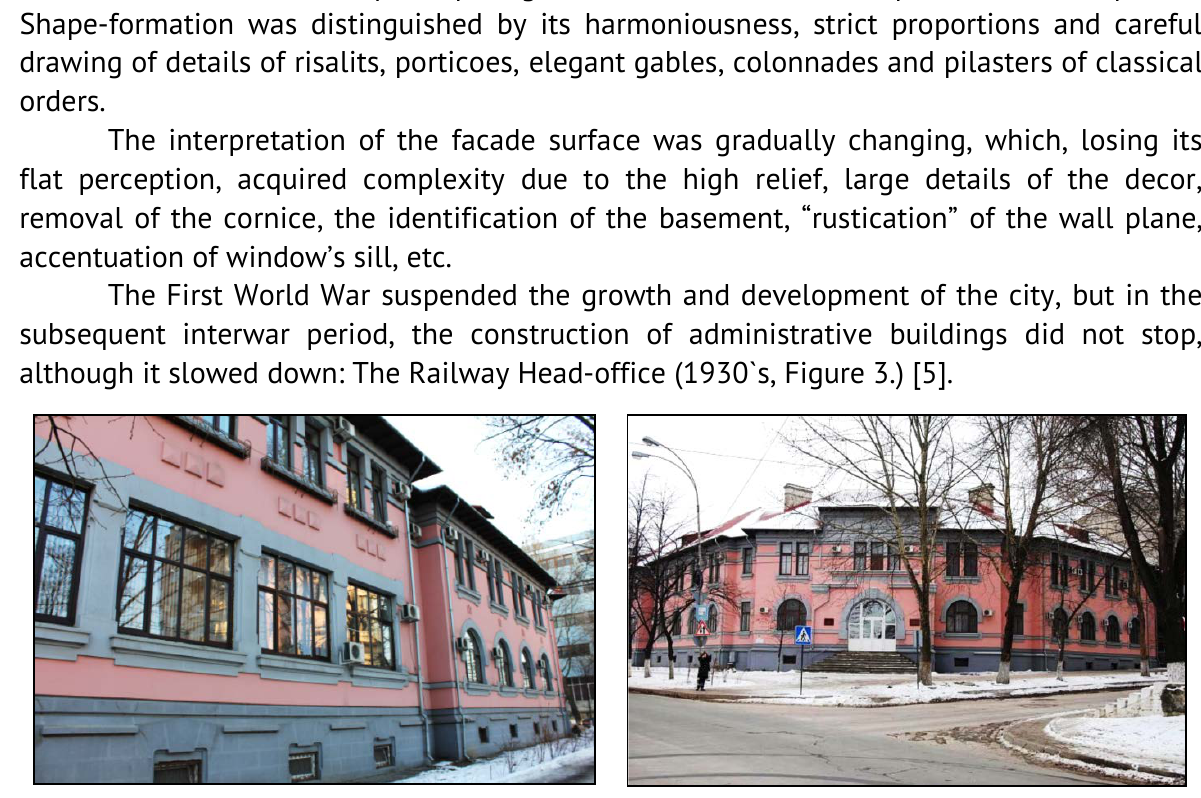
Figure 3. The Railway Head - office,